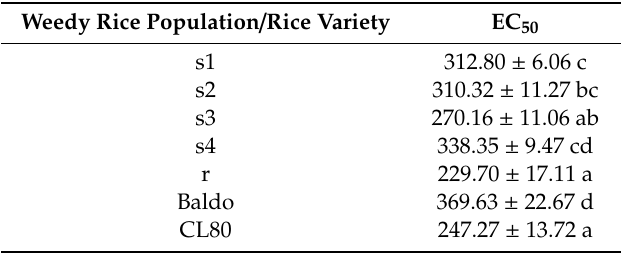
Table 2. NaCl concentrations (mM) required to reduce by 50% seed germination (EC 50 ± SE) of the tested weedy rice populations and rice varieties. Values sharing the same letters are not significantly di ff erent according to a least significant distance (LSD) test with Bonferroni adjustment ( α ≤ 0.05).